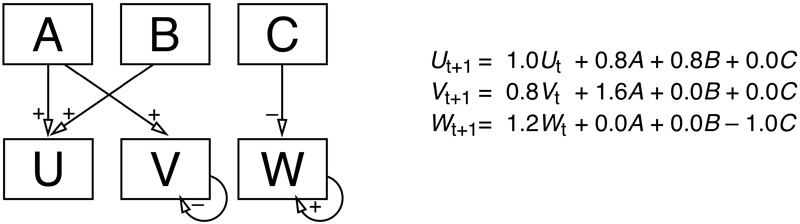
Diagram and set of equations for the causal structure of the CPS system used in this study.